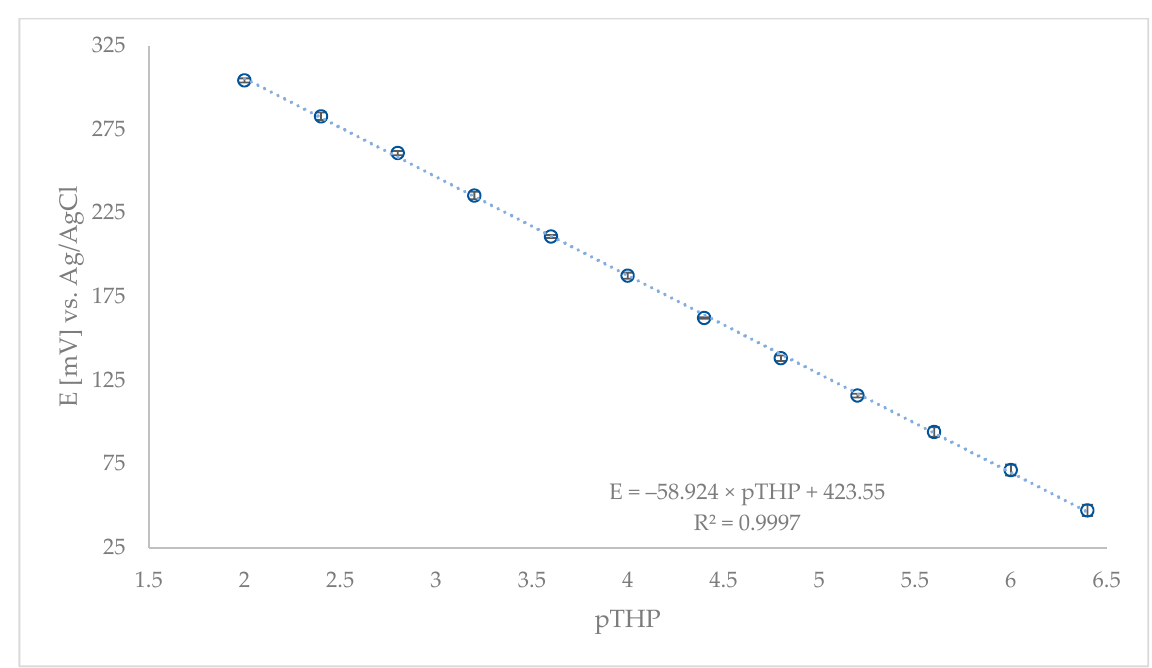
Figure 3. Calibration graph of the optimized—no. 24 CPE.